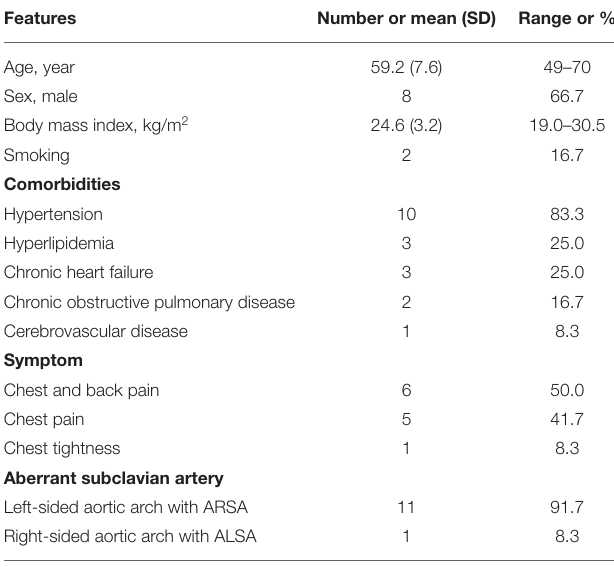
TABLE 1 | Clinical characteristics in the 12 patients with aberrant subclavian artery.